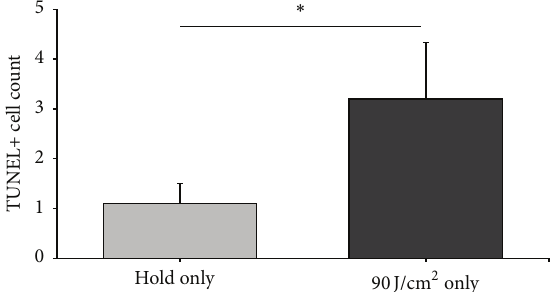
Figure 4: TUNEL+ cell count in dim-reared animals. Animals raised in dim light (no light damage) treated with 90 J/cm 2 670 nm light had three times more TUNEL+ cells compared to control animals that were hand-held only for 30 minutes to mimic treatment conditions ( 𝑛 = 3 animals for each group, “ ∗ ”denotes significance 𝑃 < 0.05 ; error bars represent SEM).